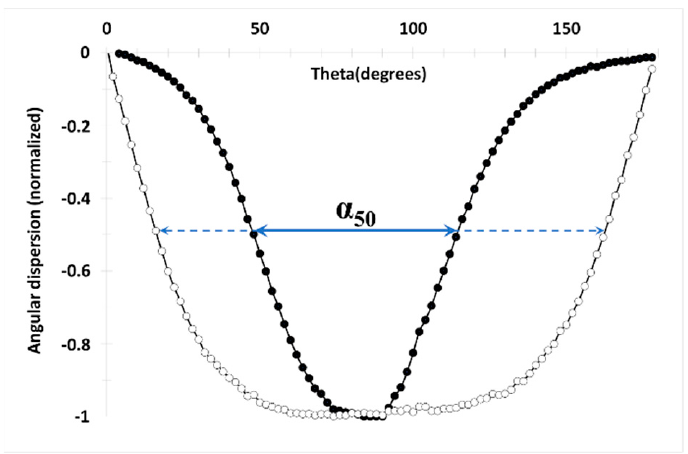
Figure 14. Measured angular dispersion and full width at half-remanence α 50 for BaM-0 (open circles) and BaM-100 (full circles).